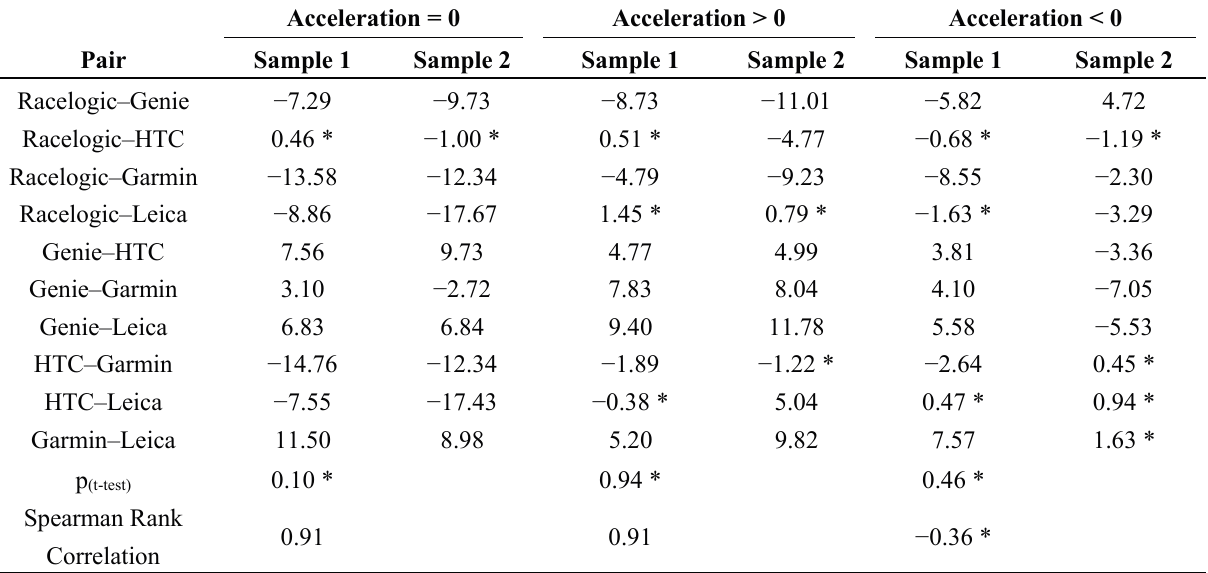
Table 4. Significance of pairwise sample t-test (p (t-test) ) and Spearman rank correlation (bottom two lines) among GNSS systems for two selected measurements; acceleration = 0; acceleration > 0; acceleration < 0 (columns show values of pairwise t-test between pairs of GNSS systems for each sample).